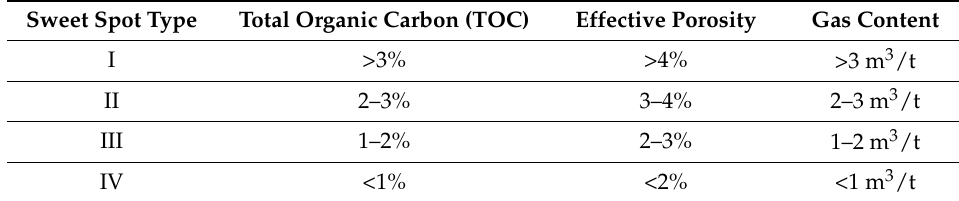
Table 3. Current evaluation index model of sweet spots in study area. Sweet Spot